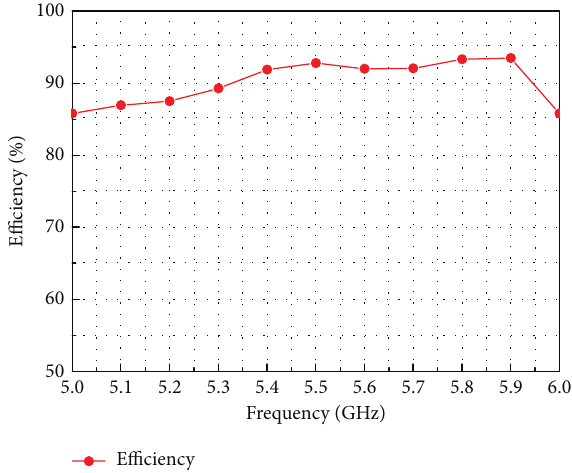
Figure 8: The total efficiency results of the proposed